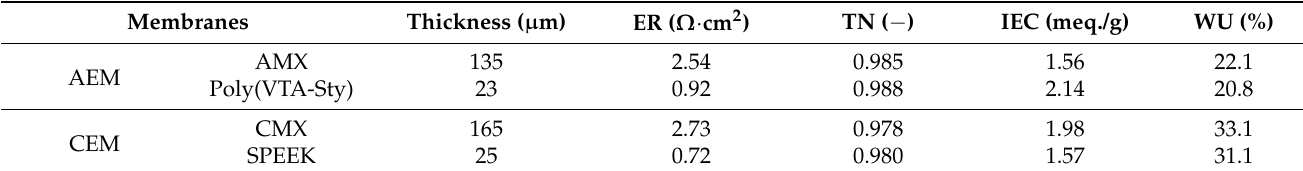
Table 3. Properties of commercial and prepared AEMs and CEMs.